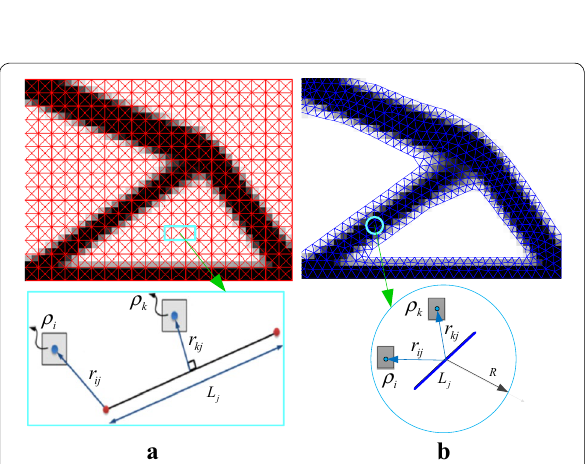
Figure 1 Mesh generation process: a topology optimization result; b obtaining density contour; c generating triangular mesh